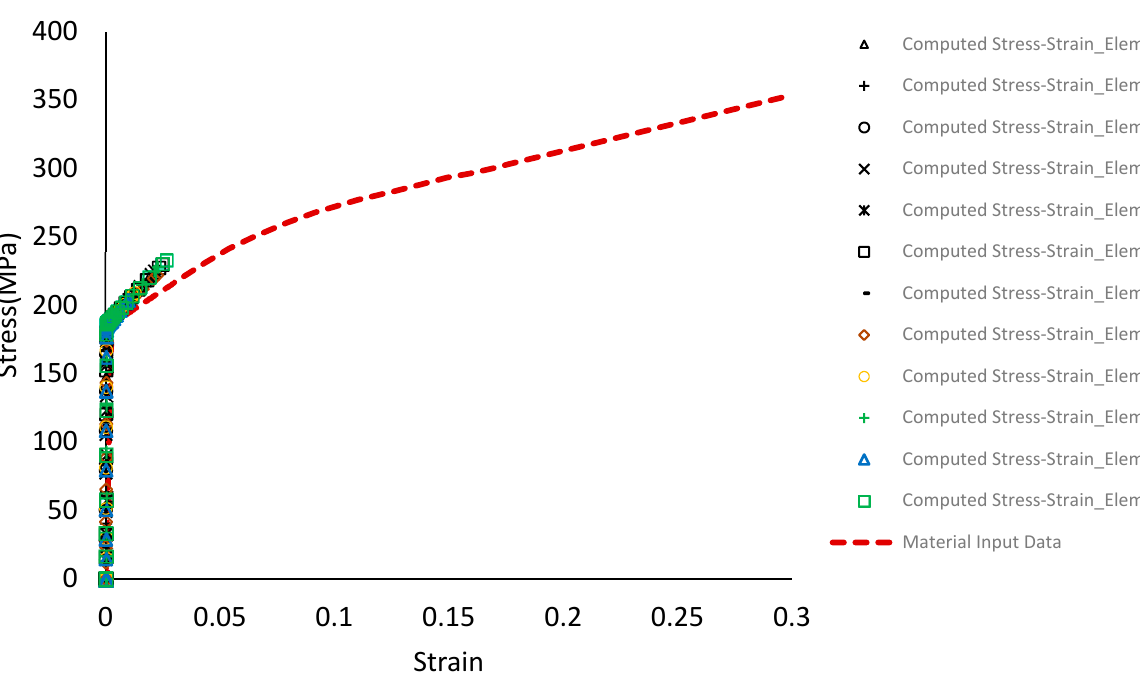
Figure 35. Stress-Strain near the U-slot of primary folding link bar.